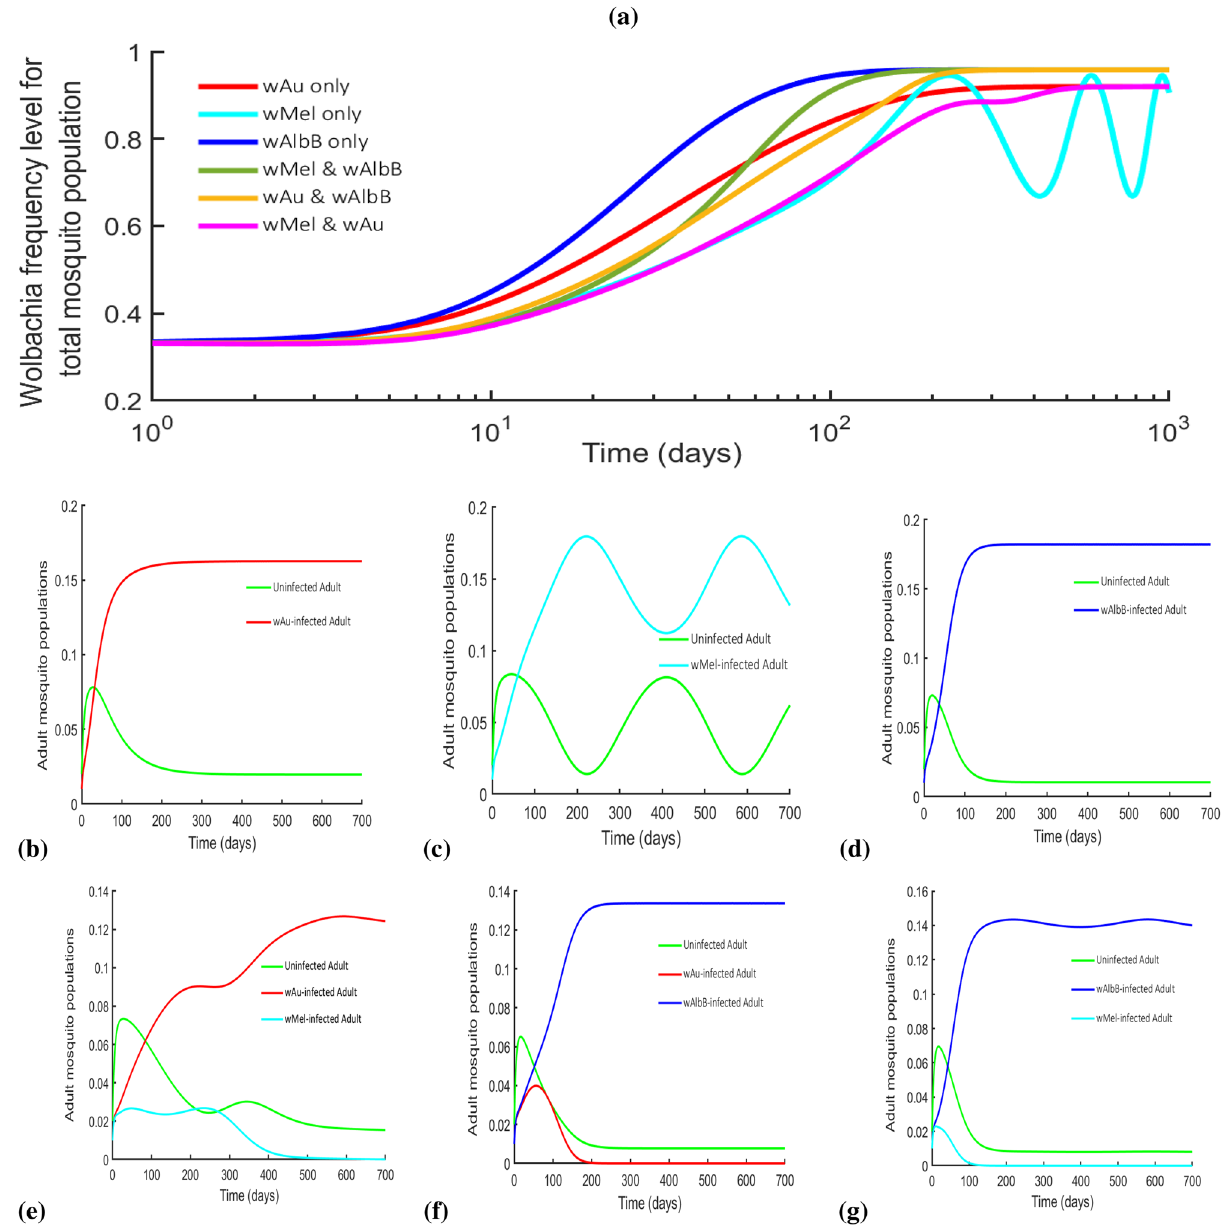
Figure 5. Wolbachia frequency levels for both single and double-strain Wolbachia -infected mosquitoes in the presence/absence of CI and Wolbachia infection loss. ( a ) Showed the Wolbachia frequency levels of both one-strain— w Au; w Mel; w AlbB, and two-strain— w Au & w AlbB; w Au & w Mel; and w Mel & w AlbB Wolbachia - infected mosquitoes, accounting for the effects of uni- and bidirectional CIs and the LWI (parameters used can be found in Table 3). (b) Showed the adult mosquitoes for w Au- Wolbachia only competition with the wild type mosquitoes as in w Au only Wolbachia frequency in (a) . (c) Showed the adult mosquitoes for w Mel- Wolbachia competition only with uninfected mosquitoes as in w Mel only in (a) . (d) Showed the adult mosquitoes for w AlbB- Wolbachia competition only with uninfected mosquitoes as shown in (a) . (e) Showed the adult mosquito population of the two strain competition of w Au and w Mel together with wild-type mosquitoes for the Wolbachia frequency of w Au and w Mel in (a) . (f) Showed the adult populations for uninfected, w Au- and w AlbB-infected mosquitoes for the Wolbachia frequency in (a) . (g) Showed the adult populations for w AlbB- and w Mel-infected mosquitoes for the Wolbachia frequency in (a)